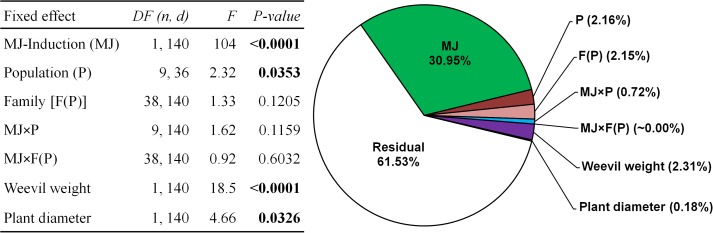
Summary of the mixed model testing the effects of the induction treatment with methyl-jasmonate (MJ), population (P), family within population [F (P)] and the MJ × P and MJ × F(P) interactions on the early resistance to herbivory by the pine weevil on plants from ten maritime pine populations. Variance components for each effect and the residual are shown in the companion pie chart. Weevil weight and plant diameter were included as covariates. Significant p-values (p < 0.05) are highlighted in bold. A total sample size of 205 genotypes was used.